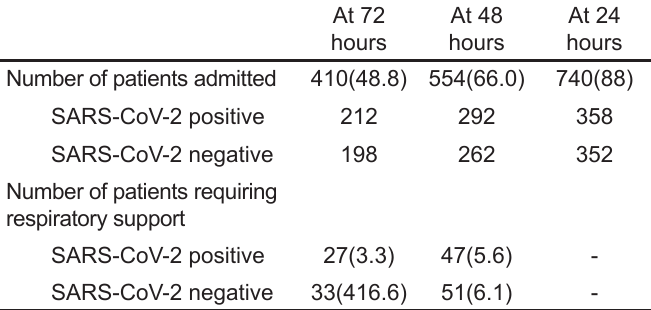
Table 3. Rates of decompensation, n